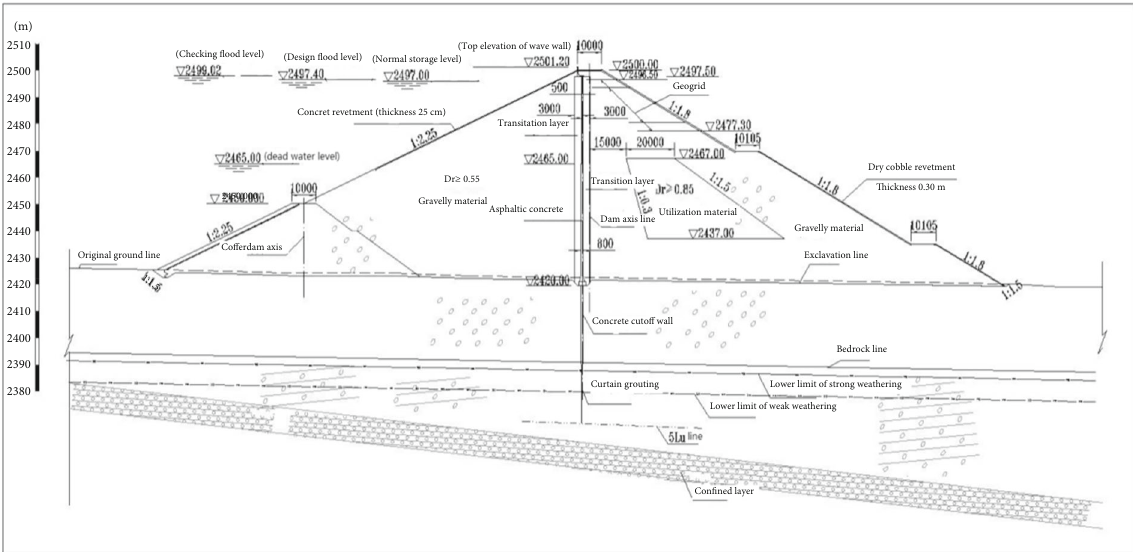
Figure 1: Typical pro fi le of